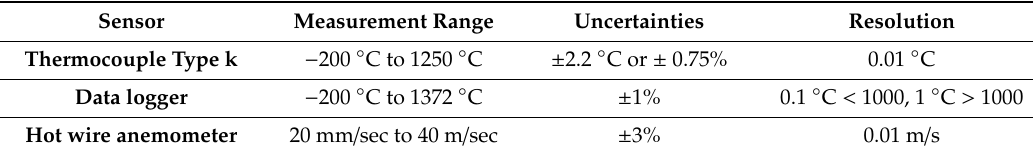
Table 2. Technical specification of the equipment.